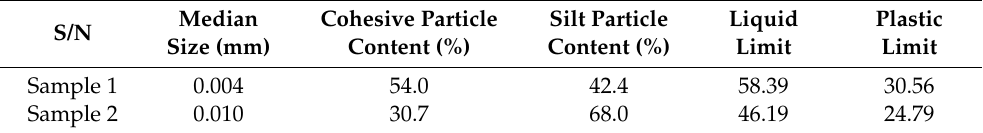
Figure 3. Particle size distribution of test soil samples. Table 1. Characteristic values of test soil